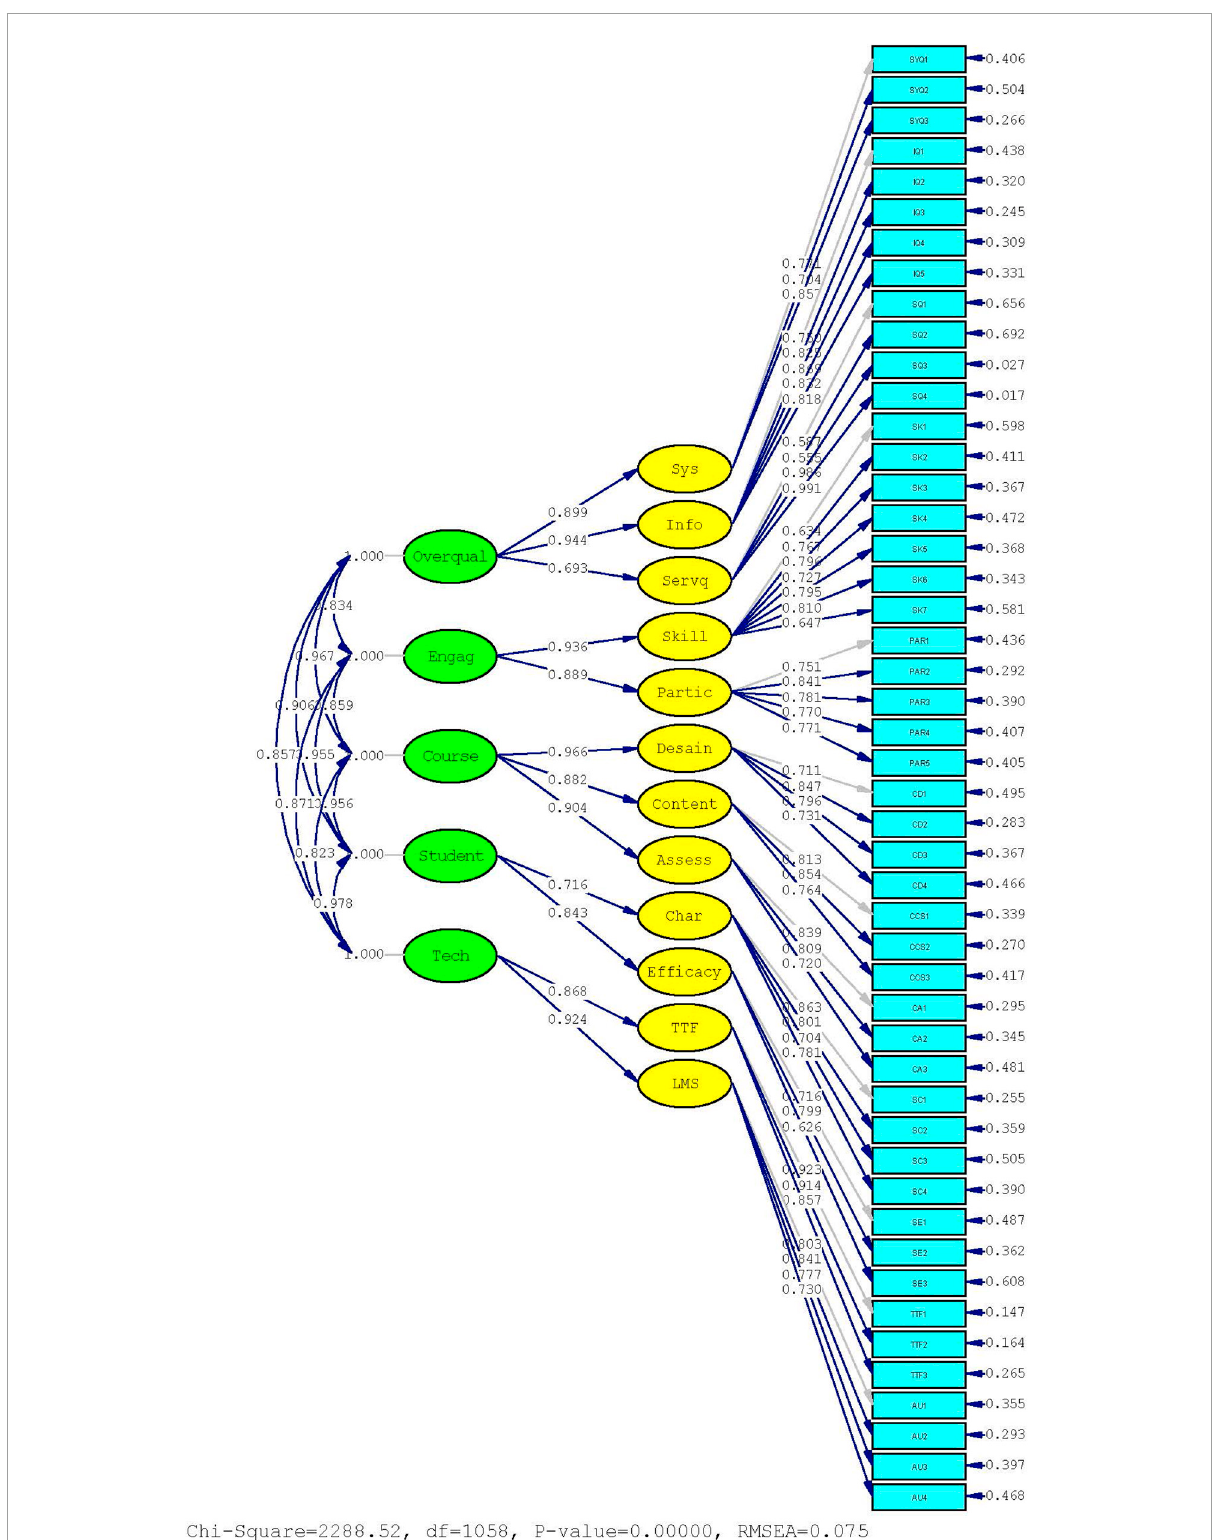
FIGURE2 Validity and reliability (second